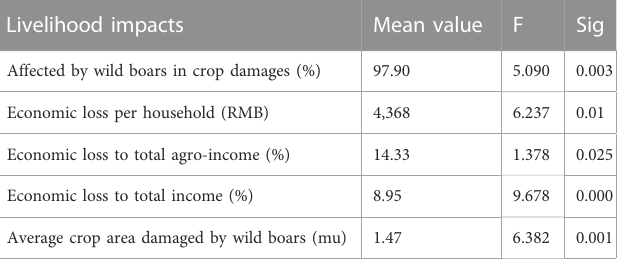
TABLE 3 Results of One-Way ANOVA of livelihood impacts for different rural households. Livelihood impacts